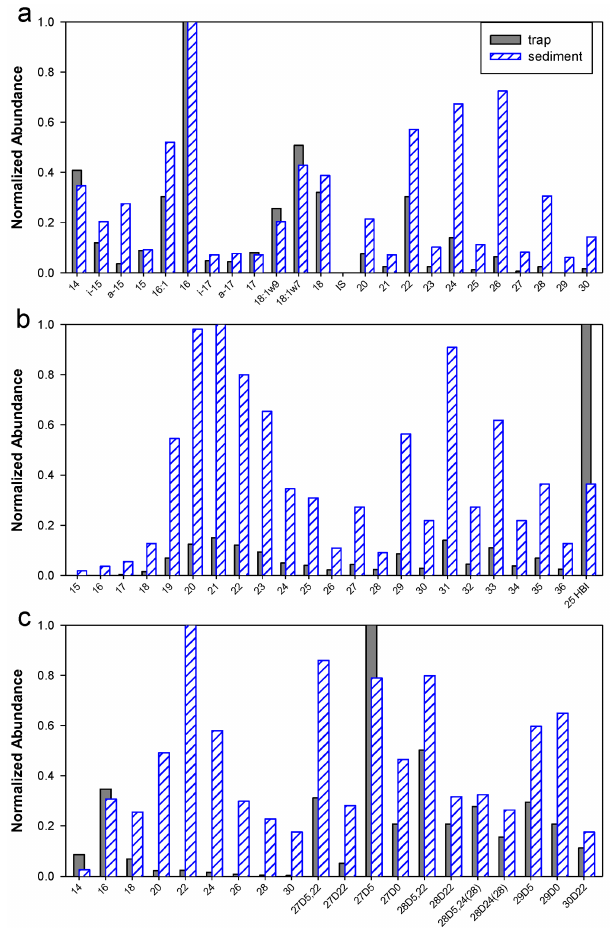
Figure 7. Histograms of relative abundances of (a) fatty acids, (b) hydrocarbons and (c) sterols/alcohols in POM and SOM from the Ross Sea. Carbon numbers are given for fatty acids, alkanes and alcohols; sterol abbreviations are 27D5,22 = 27 (cid:49) 5 , 22 ,